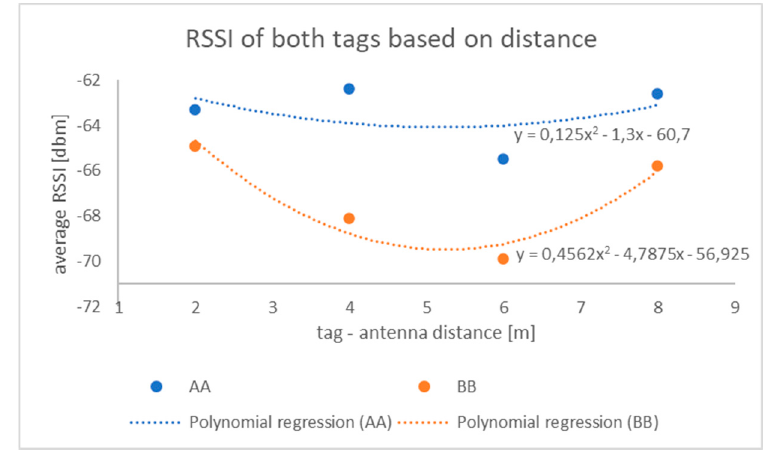
Figure 12. RSSI for tags based on